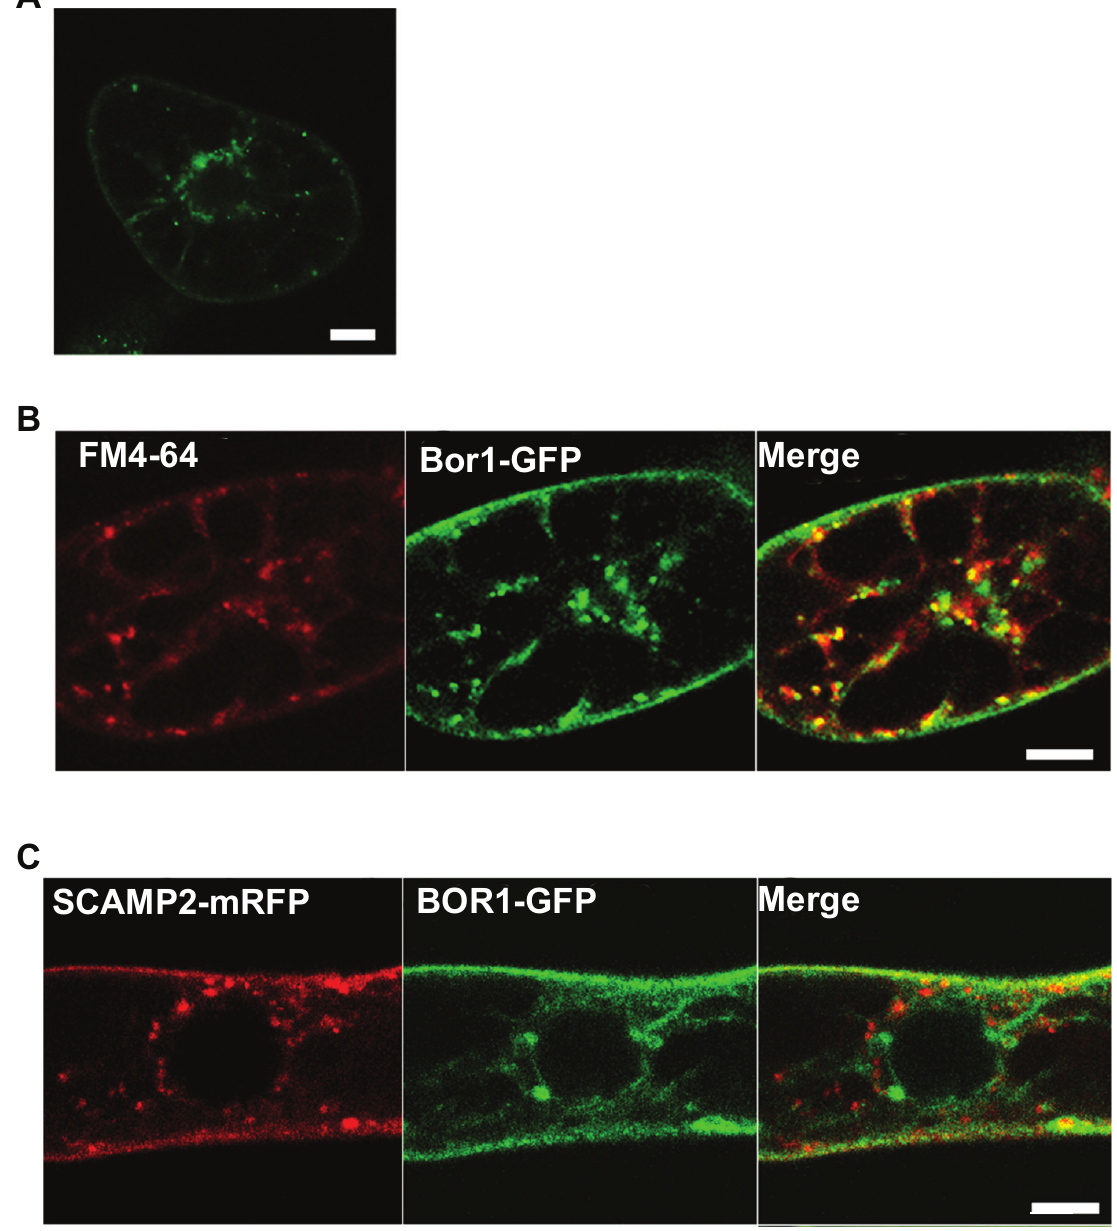
Figure 6. Endocytotic transport of BOR1-GFP during borate-induced degradation. A . Two hours after incubating the cells in medium containing 3 mM borate, cells were incubated with FM4-64 for 30 min and analyzed with a confocal fluorescent microscope. B . Many, but not all intracellular BOR1-GFP dots colocalized with puncta of FM4-64. C . BOR1-GFP did not pass through the trans-Golgi network (TGN) during degradation. BOR1-GFP was transiently expressed in cells expressing SCAMP2-mRFP, which is a marker for TGN and the secretory vesicle cluster 14 . Co-expressed cells were incubated in medium containing 3 mM borate for 2 hours and the fluorescence was analyzed by confocal laser scanning microscopy. No clear overlap of the intracellular puncta of SCAMP2-mRFP and BOR1-GFP was